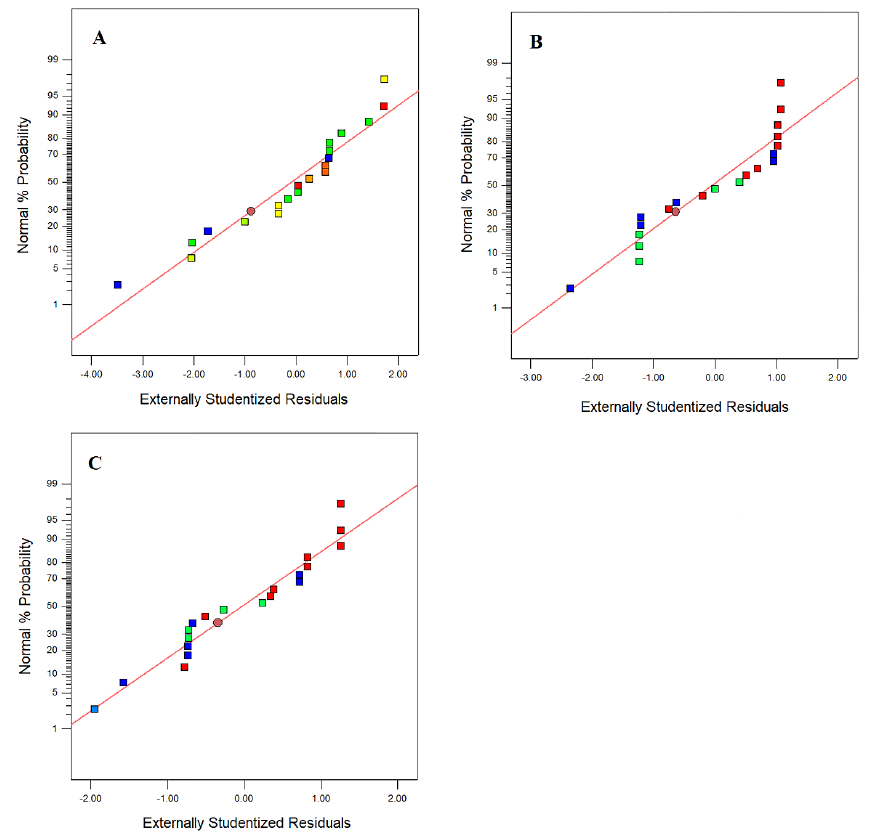
Figure 1. Normal probability plots of the residuals for size of the WDM (A), MFC (B) and MIC (C). Note . WDM, well diffusion method; MFC, minimum fungicidal concentration; MIC, minimum inhibitory concentration.